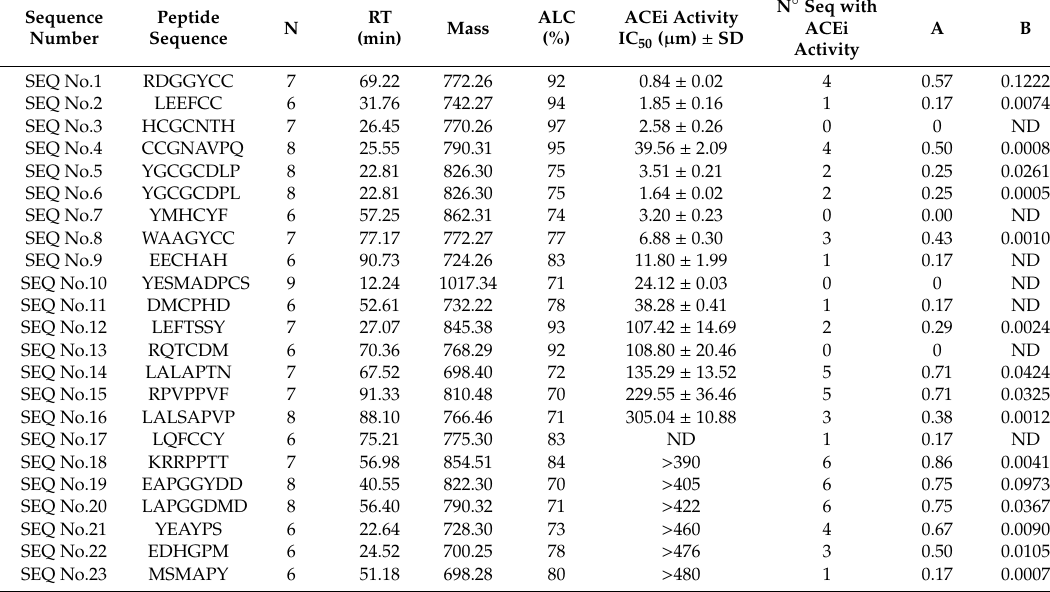
Table 1. Water-soluble peptides with ACE inhibitory activity identified in the olive oil extract using Peaks studio software and de novo sequencing. N, number of amino acids; RT, retention time; ALC, average local confidence; ACEi activity, angiotensin converting enzyme inhibitory activity; IC 50 ( µ m), peptide concentration necessary to inhibit 50% of ACE activity, expressed in µ m; A, number of sequences with ACEi activity / N; B, potential biological activity of the peptide ( µ m − 1 ) theoretically calculated from previous ACEi referenced data. A and B values obtained from the BIOPEP data base (http: // www.uwm.edu.pl / biochemia / index.php / pl / biopep).